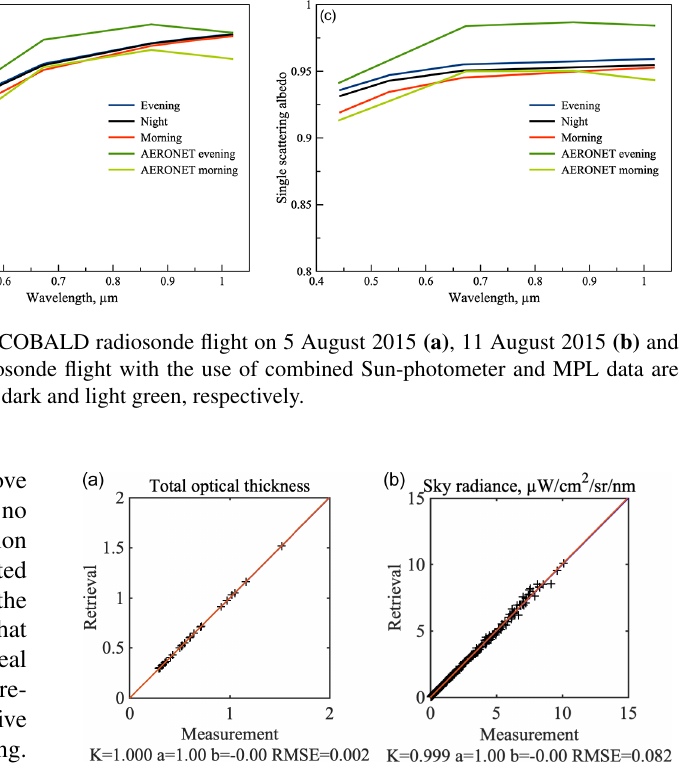
Figure 9. Achieved total optical thickness (a) and sky radiance (b) fits for the multi-temporal retrievals performed on 5, 11 Au- gust 2015 and 12 August 2016.